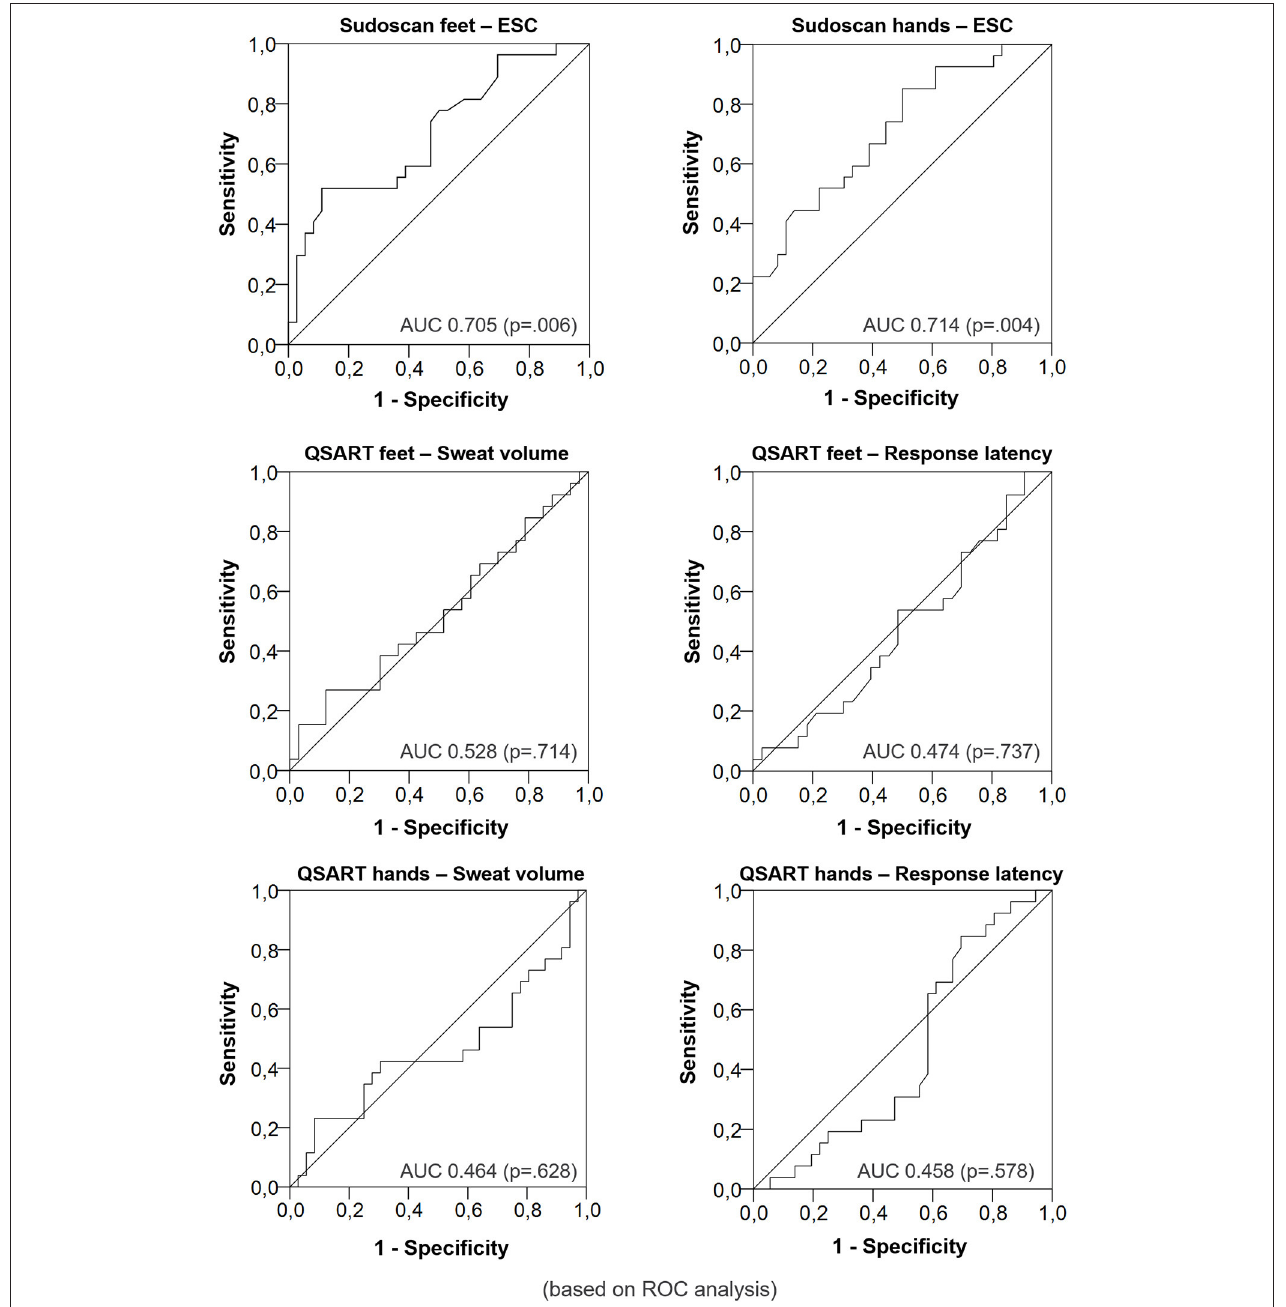
FIGURE 1 | Diagnostic performance of Electrochemical Skin Conductance vs. sweat volume and response latency for DPN (Receiver operating characteristic